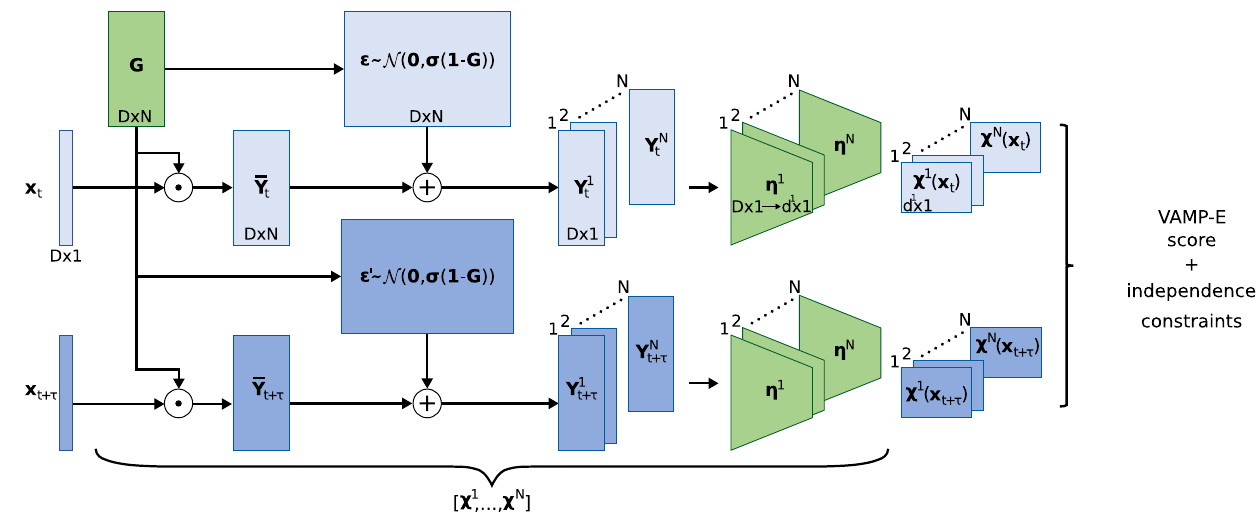
ϵ ij ∼ N ð 0, σ ð 1 (cid:2) G ij ÞÞ . This noise is added to the weighted features Y t = (cid:2) Y t + ϵ